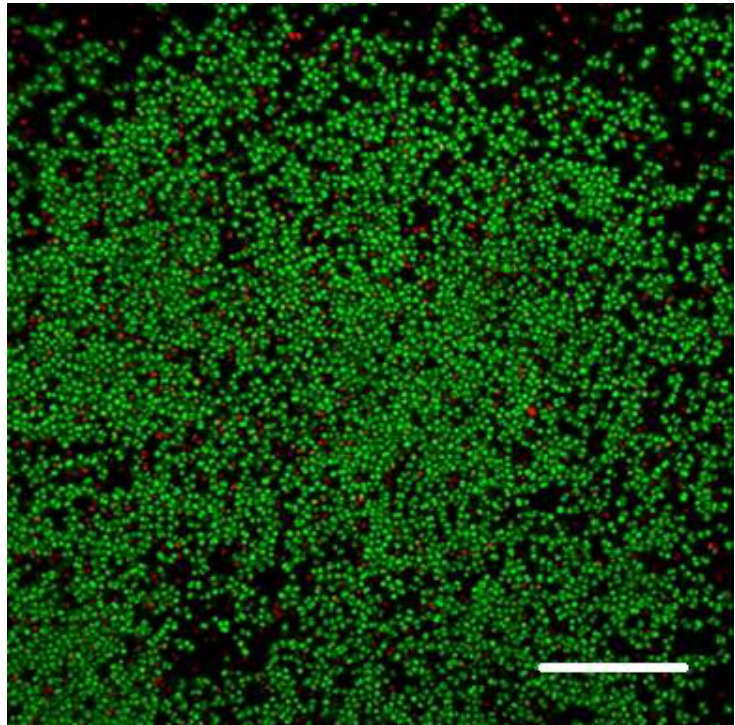
Figure 1. Cells of S. epidermidis forming a layer on the inner surface of the Ibidi flow cell channel. Single frame (slice) of a confocal stack. Composite image of green and red emission bands: green fluorescence (Syto 9) was excited with 488 nm laser; red fluorescence propidium iodide (PI) was excited with 555 nm laser; scale bar = 20 μm.